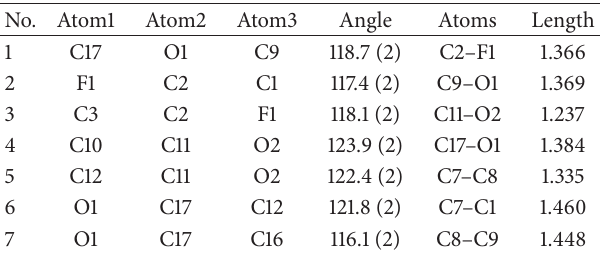
Figure 2: ORTEP diagram of a crystal of 2 󸀠 -fluoro-2-styrylchrom- one at 50% probability level. Table 1: Selected bond angles and bond lengths of 2 󸀠 -fluorosty-